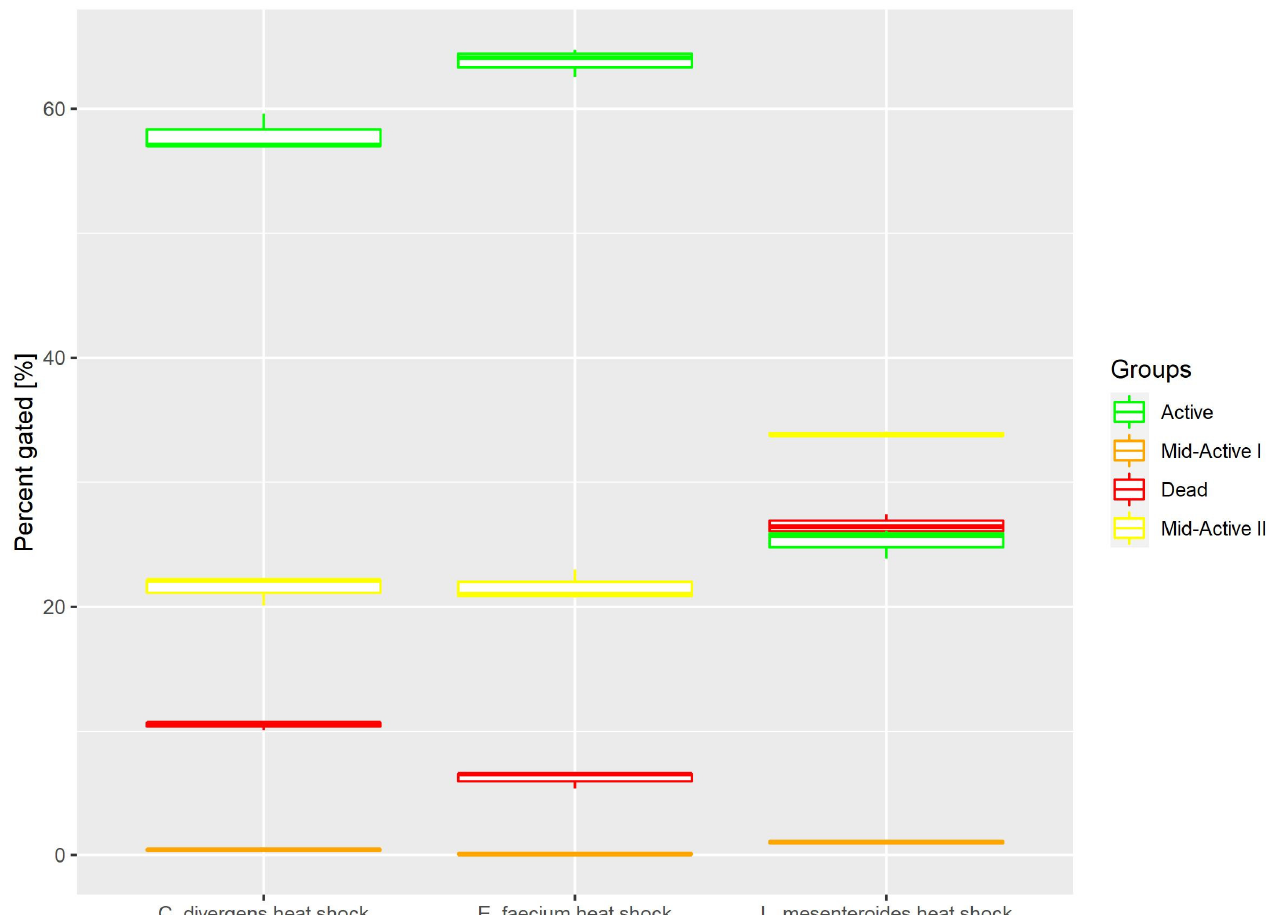
Figure 4. Cell subpopulation percentages in samples after heat shock. The distribution of cells between different groups was measured after incubating cells at 50 °C for 30 min.